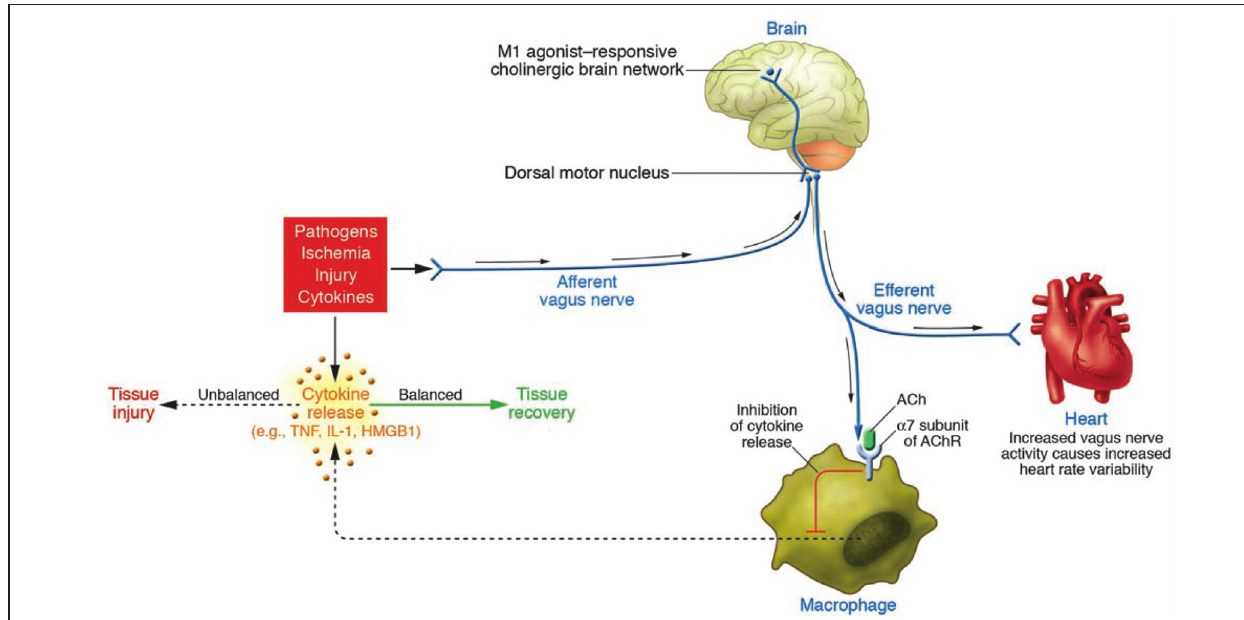
Efferent vagus nerve activity also increases instantaneous heart rate variability (HRV). A cholinergic brain network that is responsive to M1 agonists can increase the activity of CAP and also increase instantaneous HRV. Afferent signals carried in the vagus nerve can activate an efferent response that inhibits cytokine release, termed the inflammatory reflex (With permission from American Society for Clinical Investigation) (Tracey,